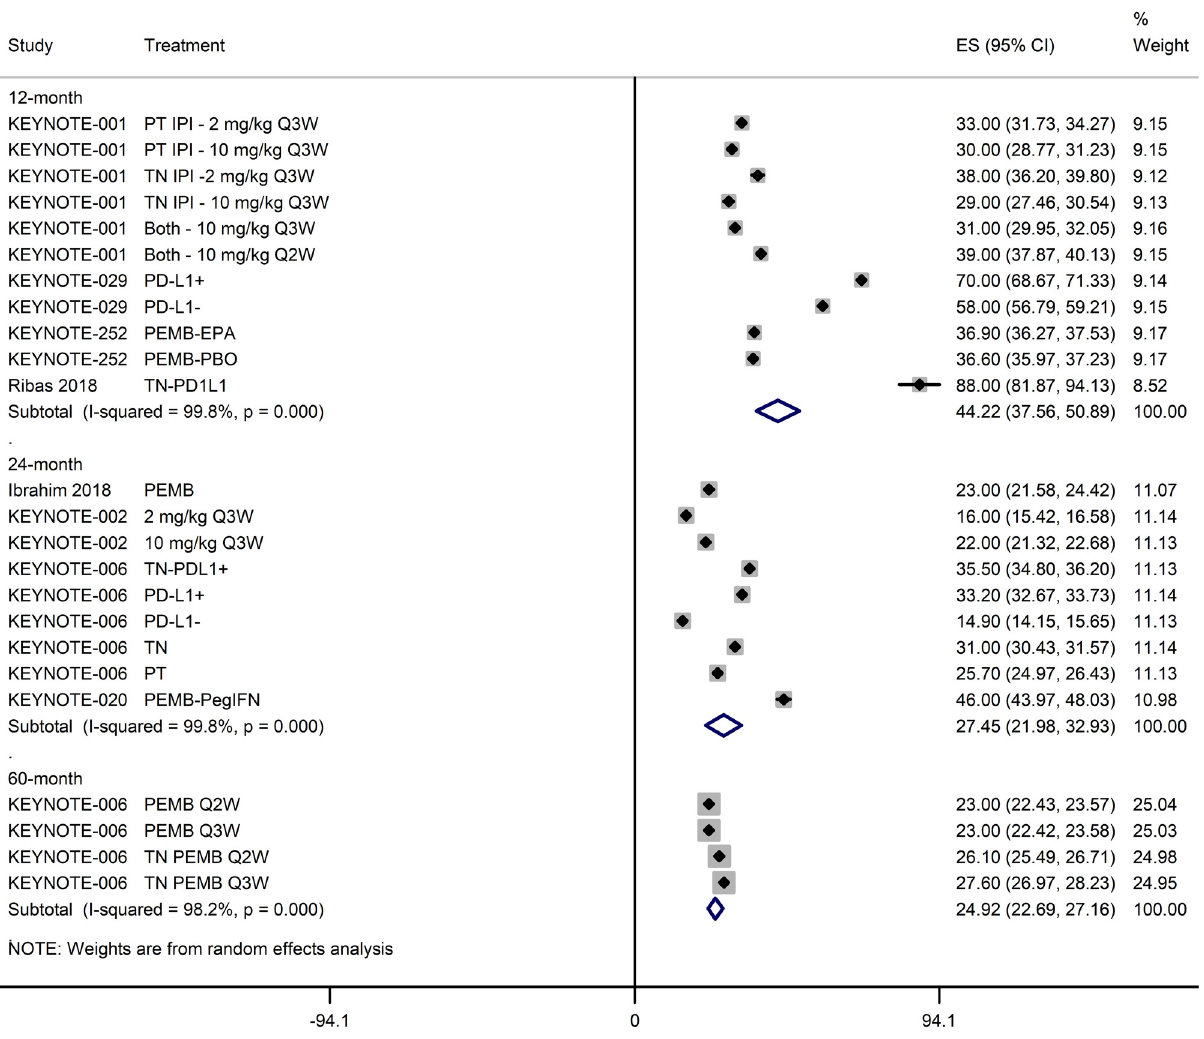
Figure 4: A forest graph showing the pooled 12 - , 24 - , and 60 - month PFS ( ES; e ff ect size with 95% CI )